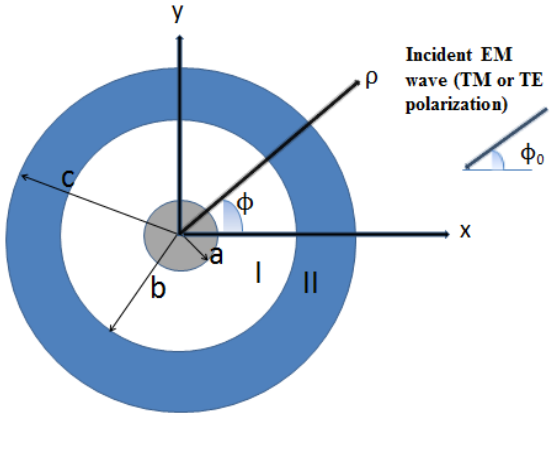
FIGURE 1. Geometry of the